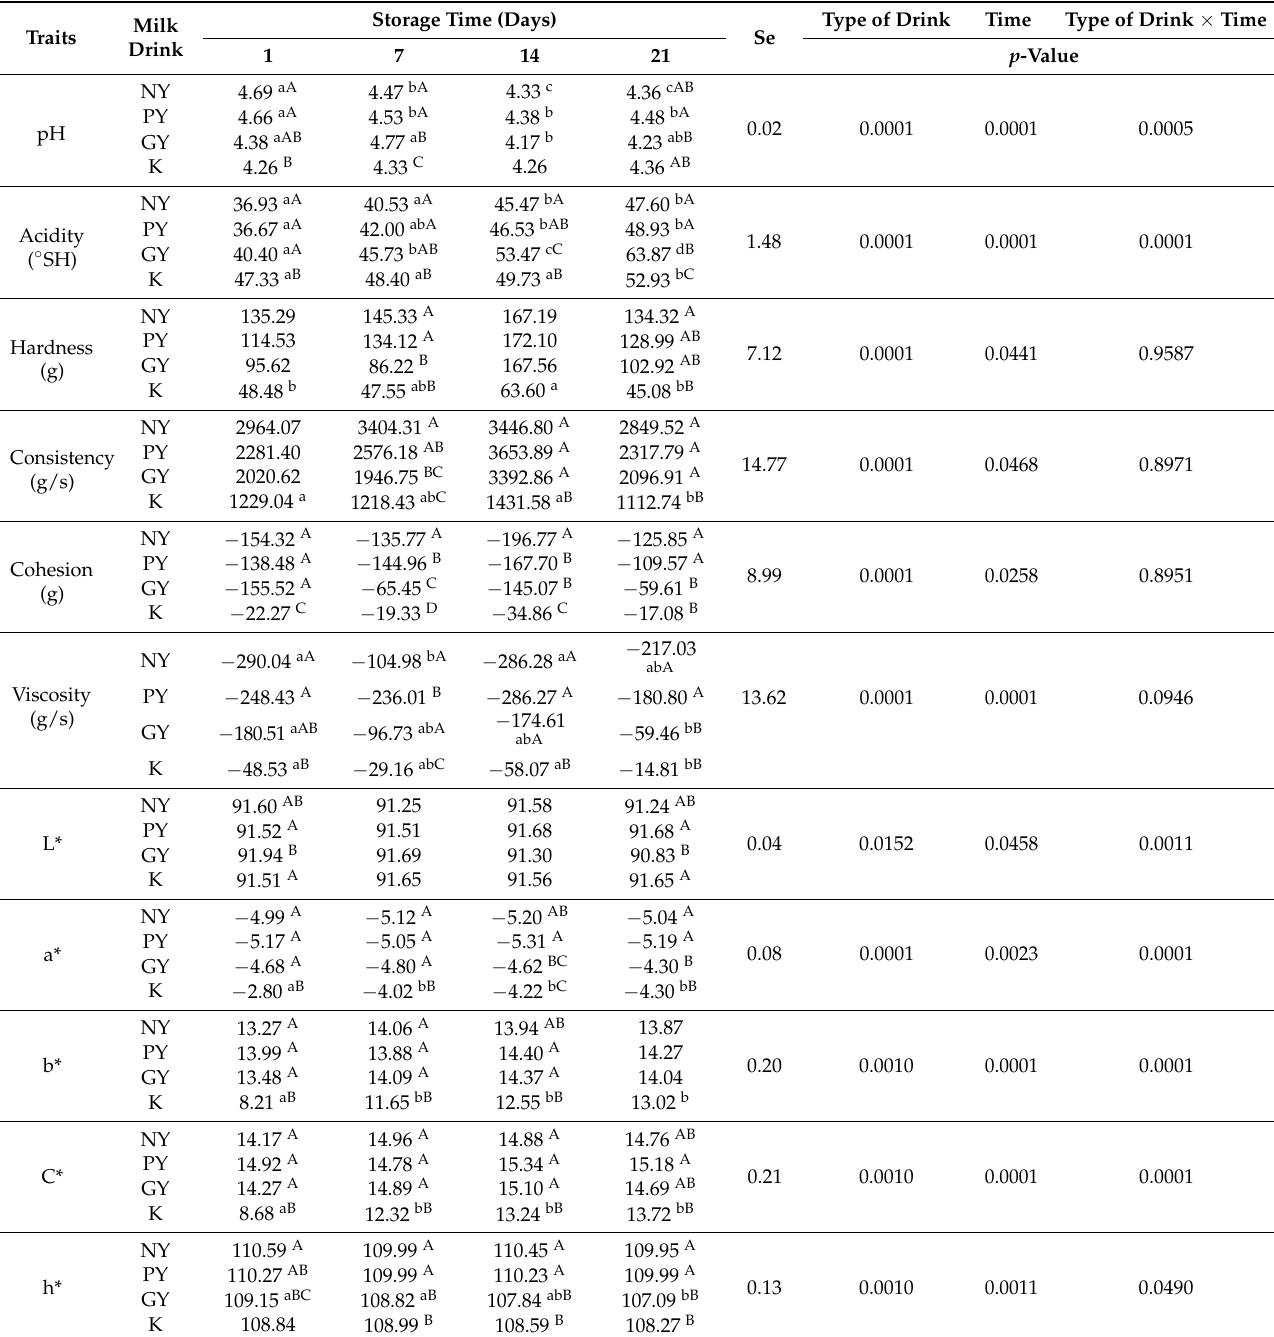
Table 3. Effect of storage time (at 4 ◦ C) and type of drink on the pH value, acidity, rheological properties, and color of fermented milk